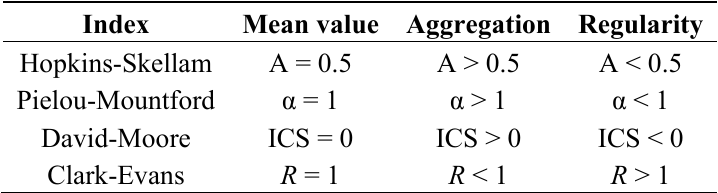
Table 2. Overview of the indices describing the horizontal structure and their common